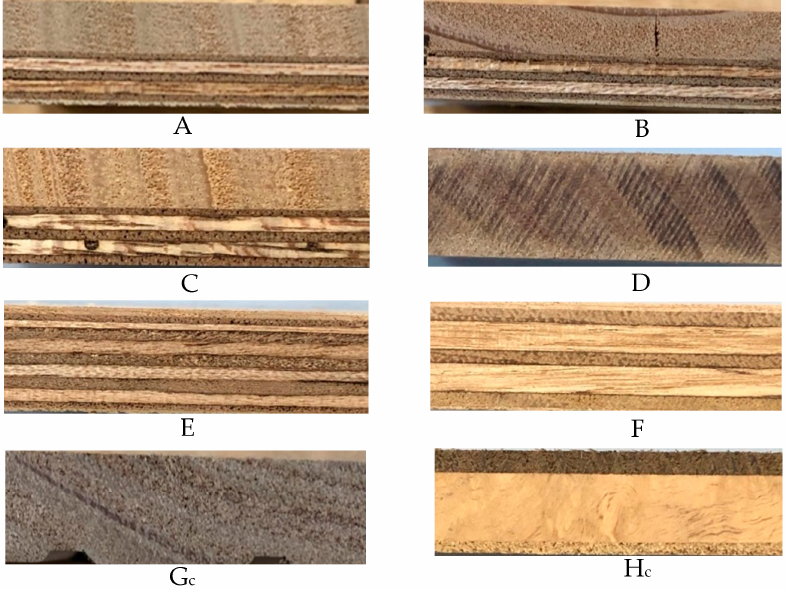
Figure 1. Cross sections of prototypes and controls ( A : 6 mm sawlog E. nitens on marine plywood substrate with veneer backing, B : 6 mm fibre E. nitens on marine plywood substrate with veneer backing, C : 6 mm sawlog E. nitens on marine plywood substrate, D : densified E. nitens , E : 1.2 mm E nitens veneer on marine plywood with veneer backing, F : 1.2 mm E. nitens veneer on fibre E. nitens plywood with veneer backing, G c : solid E. obliqua , H c : prefinished 3.2 mm Tasmanian Oak on Rubberwood